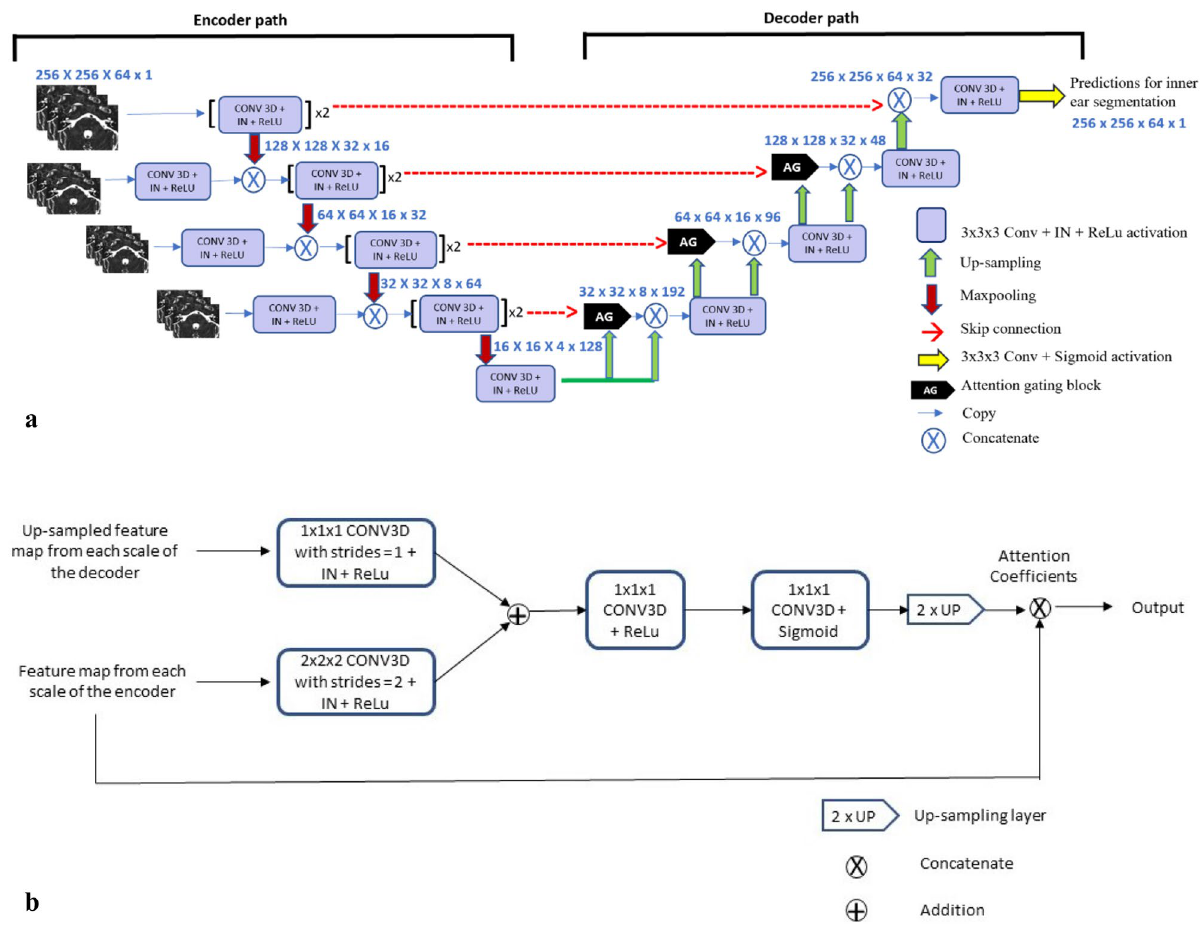
Figure 3. ( a ) The proposed 3D U-Net based architecture used in the study. MRI volumes, at multiple scales, were provided as input to the encoder network. The decoder network outputs a score to classify each voxel as inner ear or not. Notations in blue text (a × a × a × b) highlight the spatial resolution (a × a × a) and the feature map count (b). X block repetitions, IN instance normalization, Conv convolution kernel, ReLU rectified linear unit, 3 × 3 × 3 the size of the 3D CNN kernels. ( b ) Components of Attention Gating Block. The block receives as inputs, the up-sampled output feature map at each scale in the decoder and the feature map from each scale of the encoder. Attention coefficients generated, scale the input feature maps from the